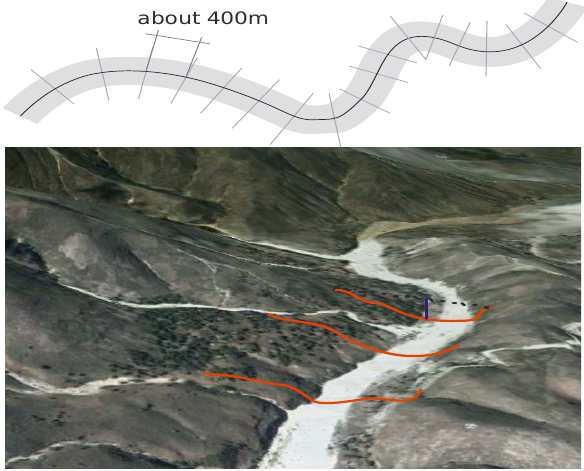
Figure 2. Cross-sectionsscheme (up) and a virtual representation of cross-sections cutlines over the DEM of the River Soliette Considering the two high-resolution DEMs, the constrains were set considering a river reach corresponding to difference of thalweg altitude between the upstream and downstream sections of about 10m (i.e length of the reach ~200m), while the area width was identified by surveying lateral slopes up to 10m above the bottom of the riverbed (see Figure